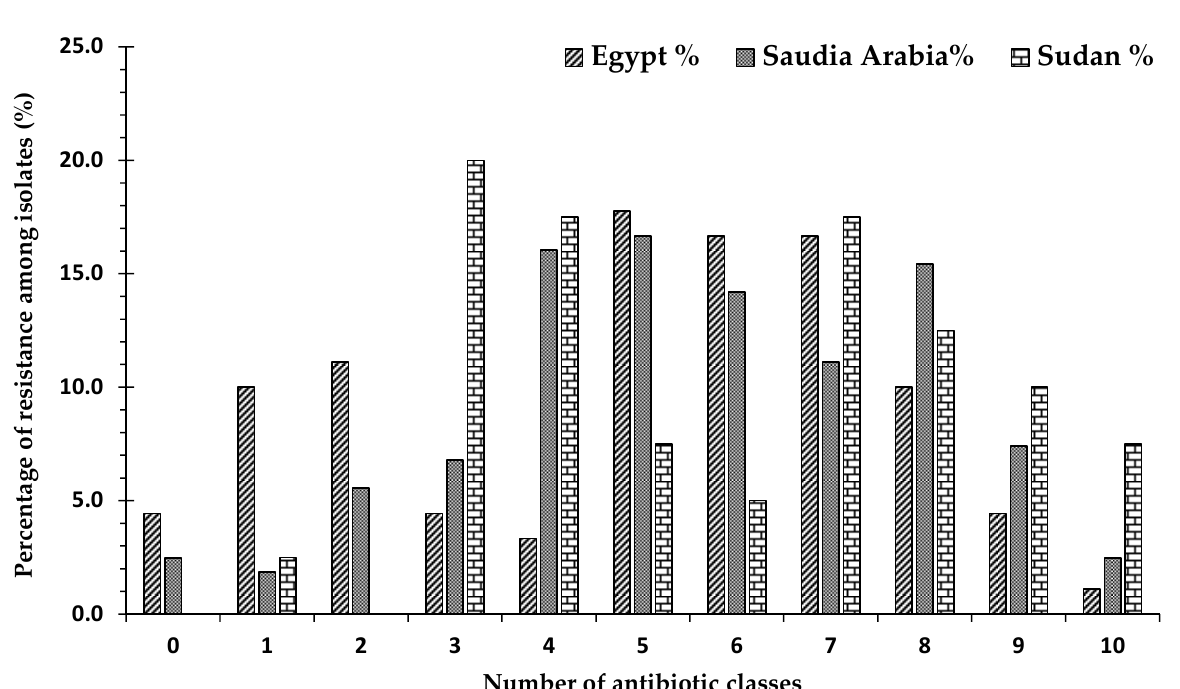
Figure 3. The percentages of strains resistant to antimicrobial agents from 11 antibiotic classes from all bacterial strains isolated from Egypt, Sudan, and Saudi Arabia: 0 means the percentage of strains obtained from a country that were not resistant to any antibiotic group (sensitive to all groups); numbers 1–10 indicate the numbers of classes that the bacterial strains showed resistance to; 1 indicates the percentage of strains obtained from this country that showed resistance to only one class of antibiotic; 2 indicates the percentage of strains obtained from a country that showed resistance to two classes of antibiotics amongst the 11 well known antibiotic classes, etc.